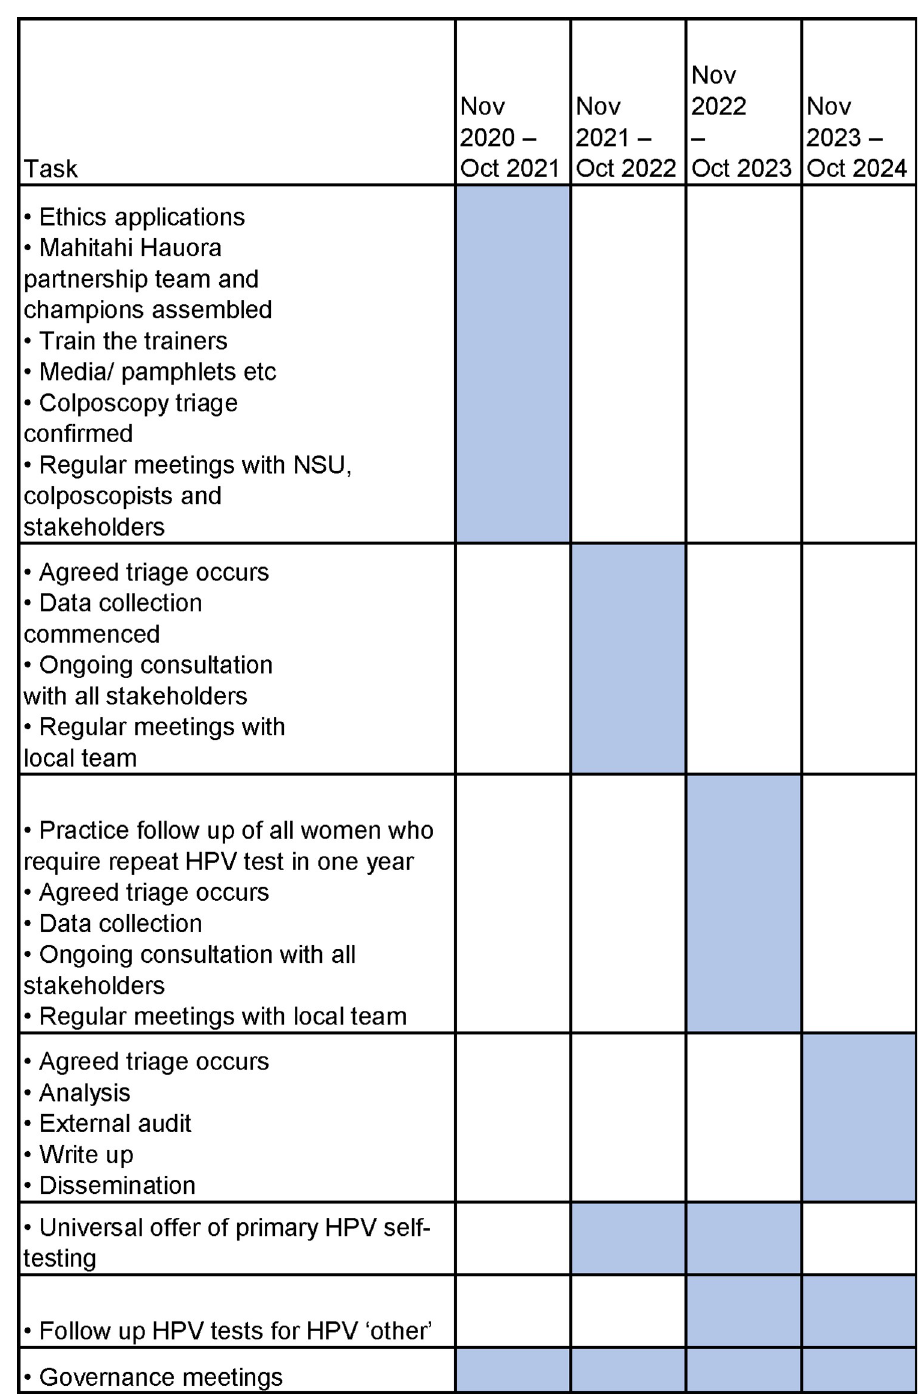
Fig 5. Te Ara Waiora–Implementing human papillomavirus (HPV) primary testing in Aotearoa New Zealand: Study timeline.